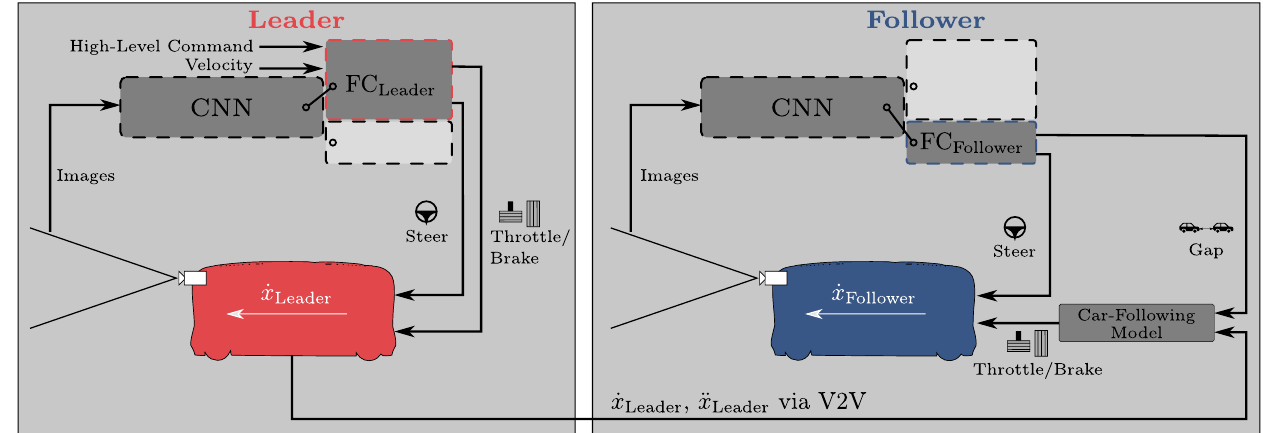
Figure 1. Overview of the proposed system. The leading and following vehicle use the same multi-task network architecture (for details, see Figure 2), but activate different prediction heads. The acceleration and velocity of the leading vehicle are transmitted to the following vehicle via V2V. Details on the car-following model used in the following vehicle can be found in (2).